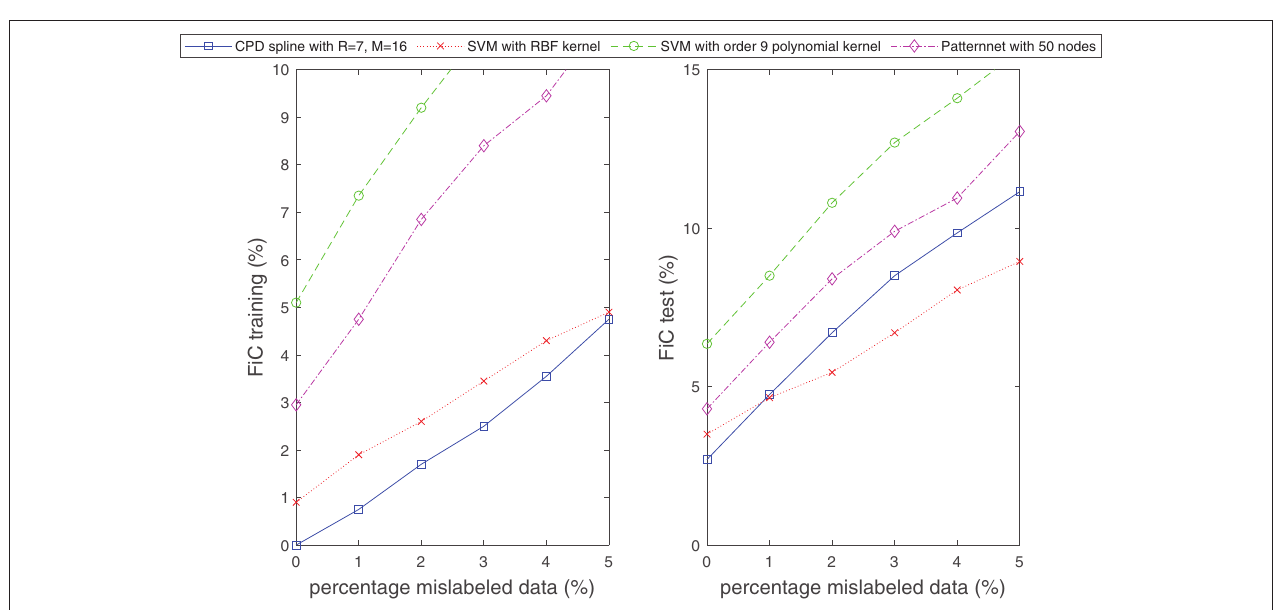
FIGURE 14 | Similar to well-established techniques for classification, the classifier (Equation 21) is robust against mislabeled data. Shown are the obtained results for the classification problem considered in Figure 11 , however, now in a situation where a particular percentage of data is intentionally mislabeled. The number of samples for the training and test dataset is set to